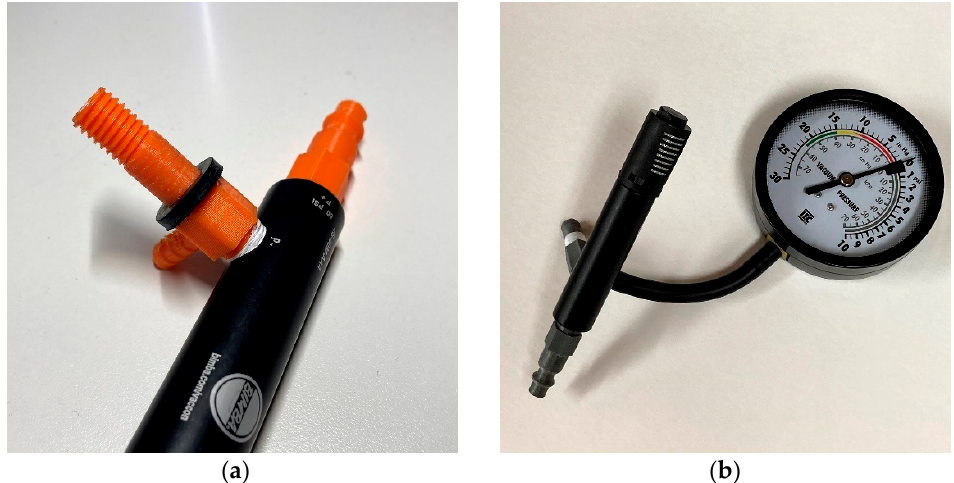
Figure 3. Assemble the air ejector. ( a ) Thread the 3-D printed connectors into the air ejector, using PTFE tape if necessary; ( b ) attach the vacuum gauge to the hose barb. Note that the same parts were printed in orange (left) and grey (right) PLA.